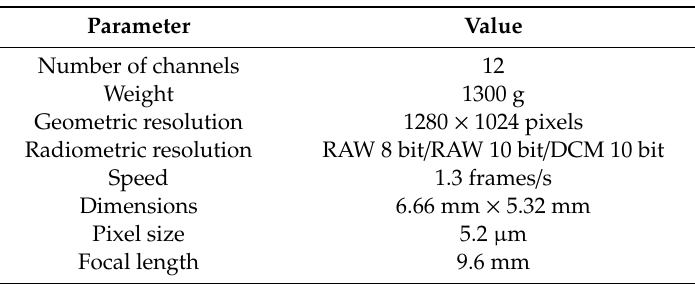
Figure 2. Mini-MCA12 multispectral camera. Table 1. Specifications of Mini-MCA.